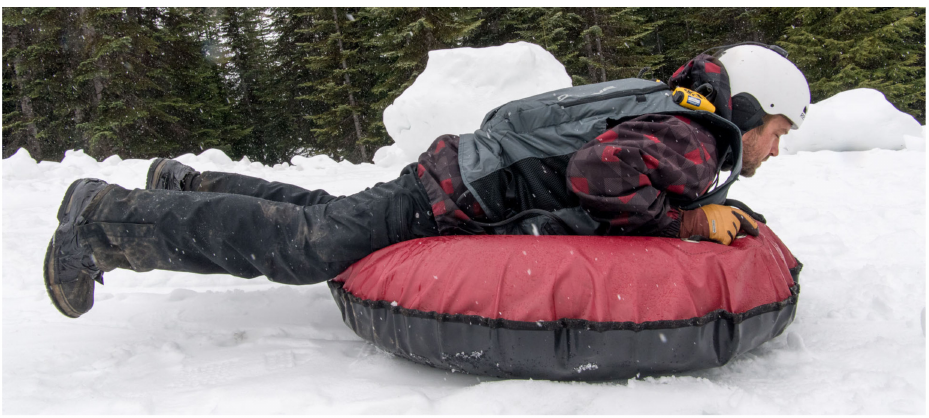
Figure 1. Participant riding position on a snow tube. The participant is wearing the kinematic body suit under his winter clothing.